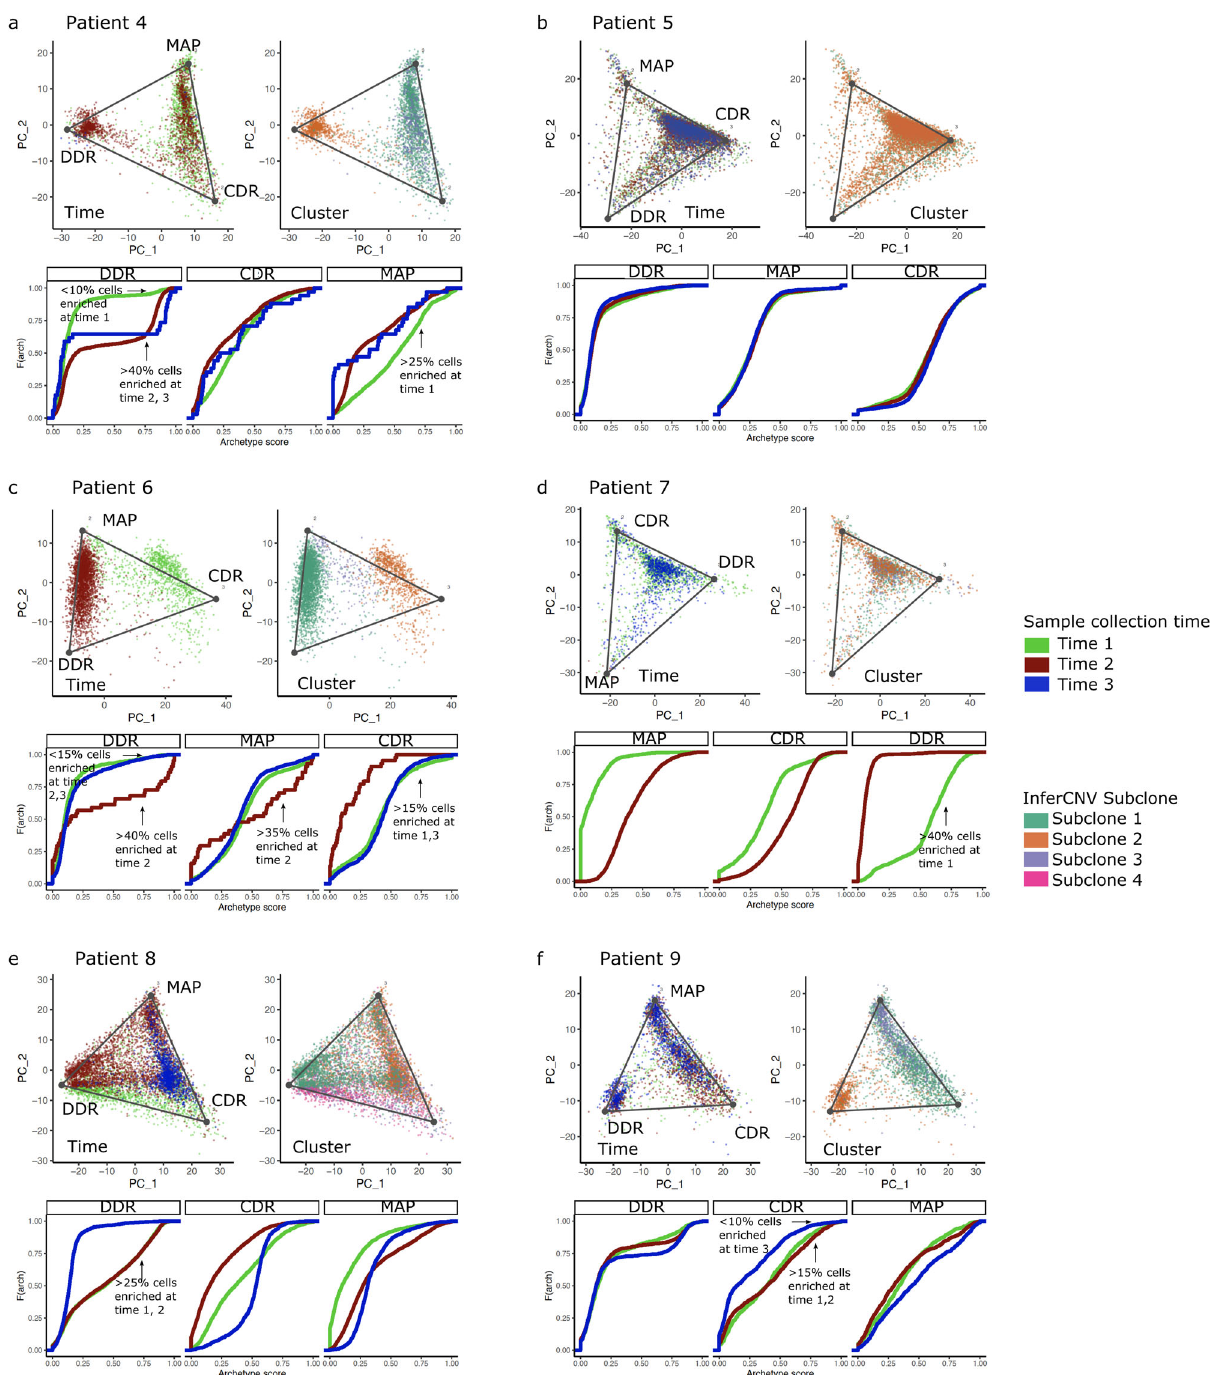
Fig. 8 Mapping archetypes to time and inferred subclones. a – f The top two panels display archetypes on the fi rst two principal components of each longitudinal cohort patient. The panel on the left shows archetype projections on cells colored based on sample collection time, while the right panel shows cells colored based on clusters identi fi ed using the inferred CNV algorithm. The empirical cumulative distribution functions of the archetype scores at each time point. Shifts in enriched archetypes, de fi ned by an archetype score >0.8, are annotated on the